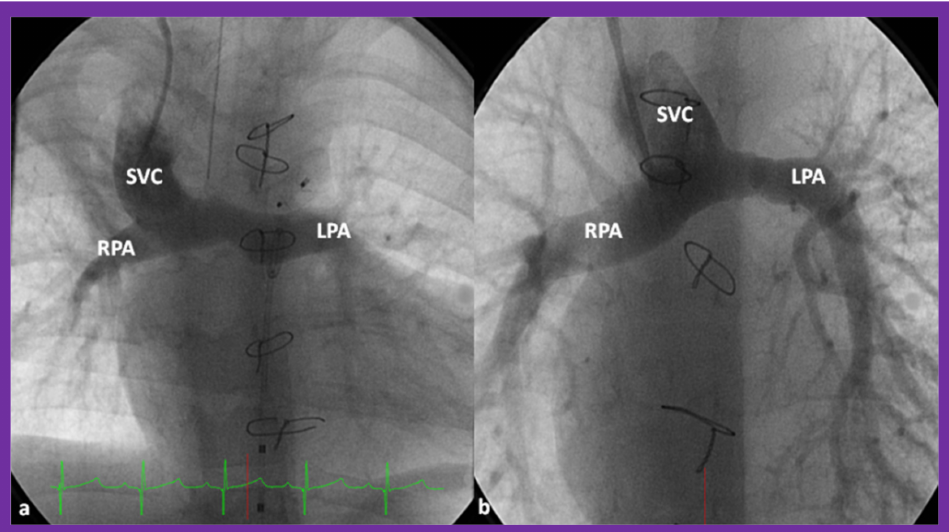
Figure 12. Cine-angiographic images illustrating bidirectional Glenn procedure in two separate children ( a , b ). The unimpeded flow of blood from the superior vena cava (SVC) to the right (RPA) and left (LPA) pulmonary arteries is demonstrated. Sternal wires related to previous surgical procedures are shown and are not labeled. Reproduced from Reference